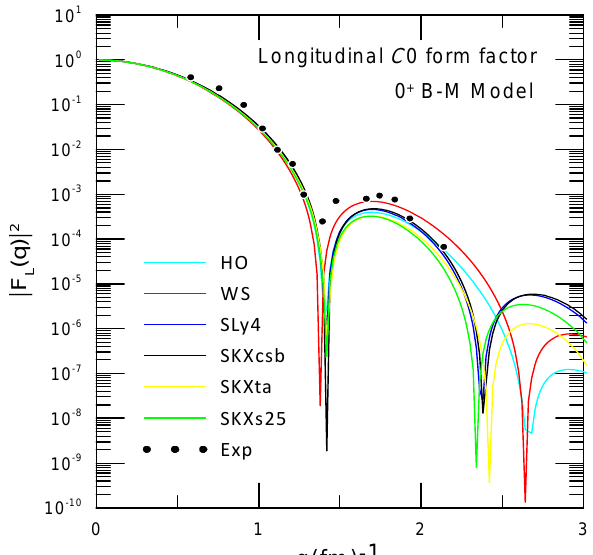
Fig. 1: Theoretical elastic longitudinal form factors for the 0 + , using HO, WS potential and SLy4, SkXcsb, SKXta and SKXs25 parametrizations, compared with the experimental data taken from Ref.